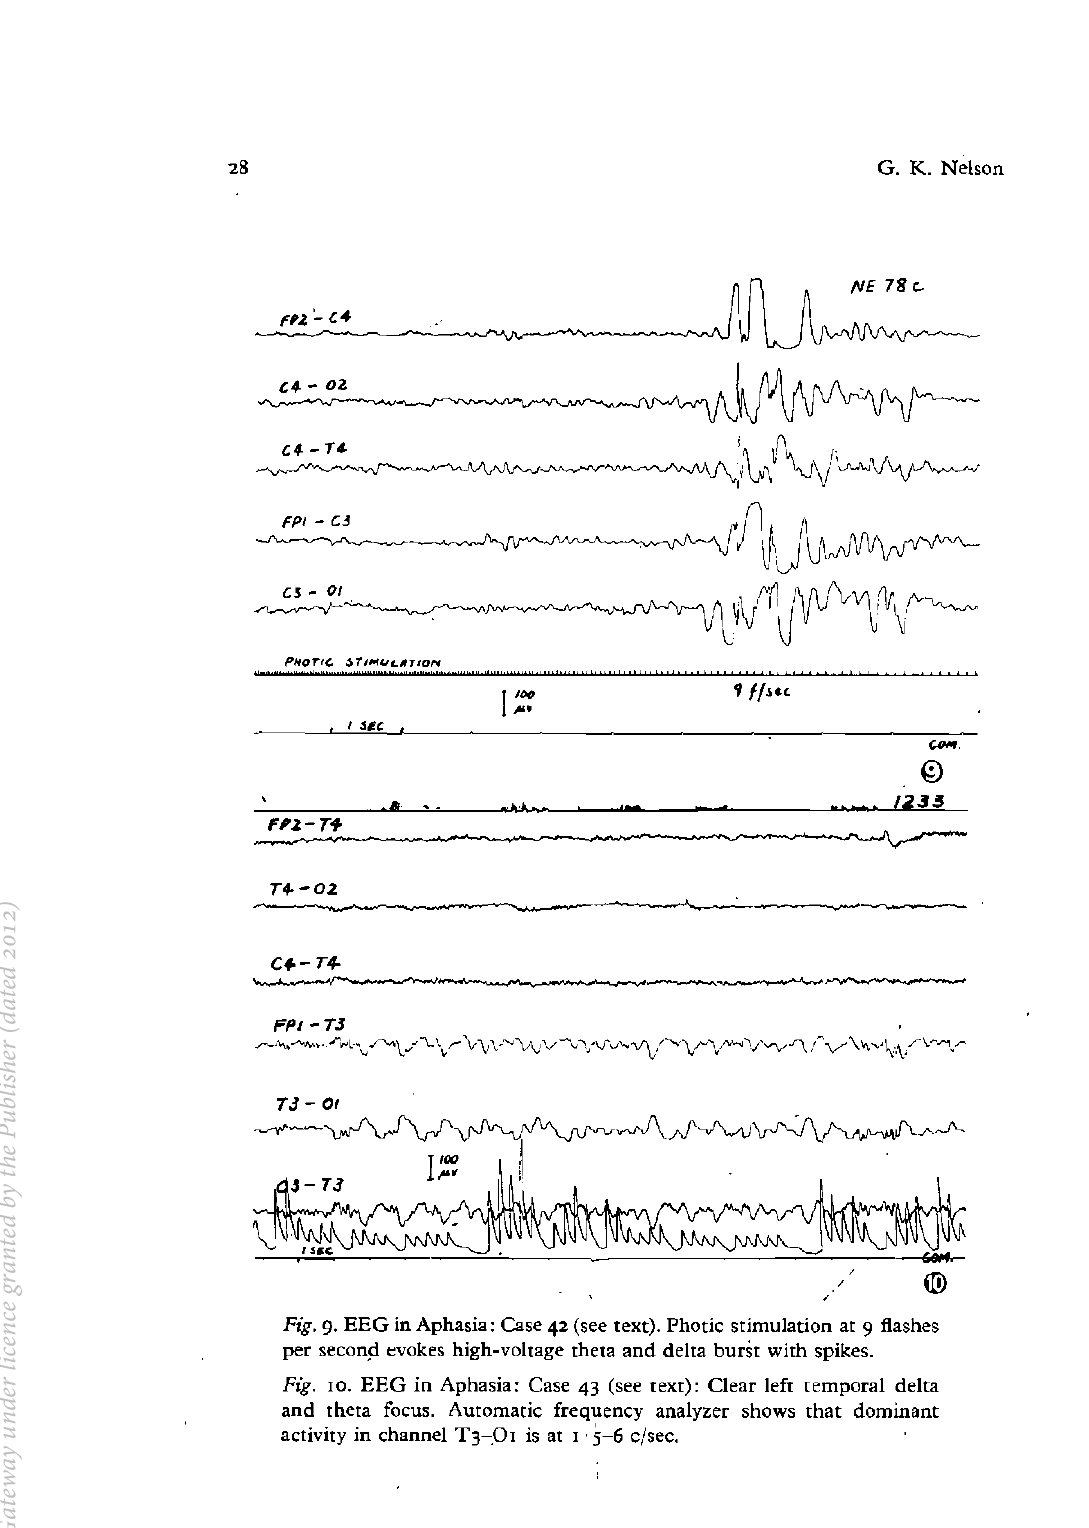
Fig. 9. EEG in Aphasia: Case 42 (see text). Photic stimulation at 9 flashes per second evokes high-voltage theta and delta burst with spikes. Fig. 10. EEG in Aphasia: Case 43 (see text): Clear left temporal delta and theta focus. Automatic frequency analyzer shows that dominant activity in channel T3-.O1 is at 1 · 5-6